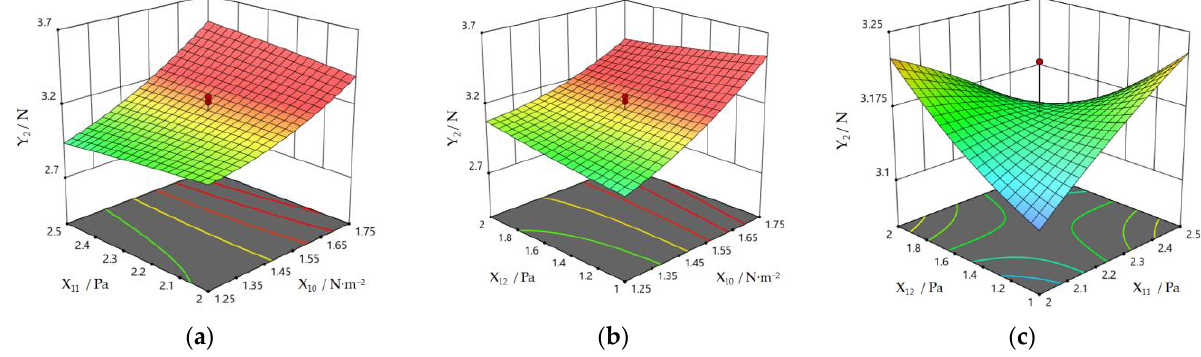
Figure 8. Effect of the interaction between factors on the maximum crushing force: ( a ) response surface under factors X 11 and X 10 ; ( b ) response surface under factors X 10 and X 12 ; and ( c ) response surface under factors X 11 and X 12